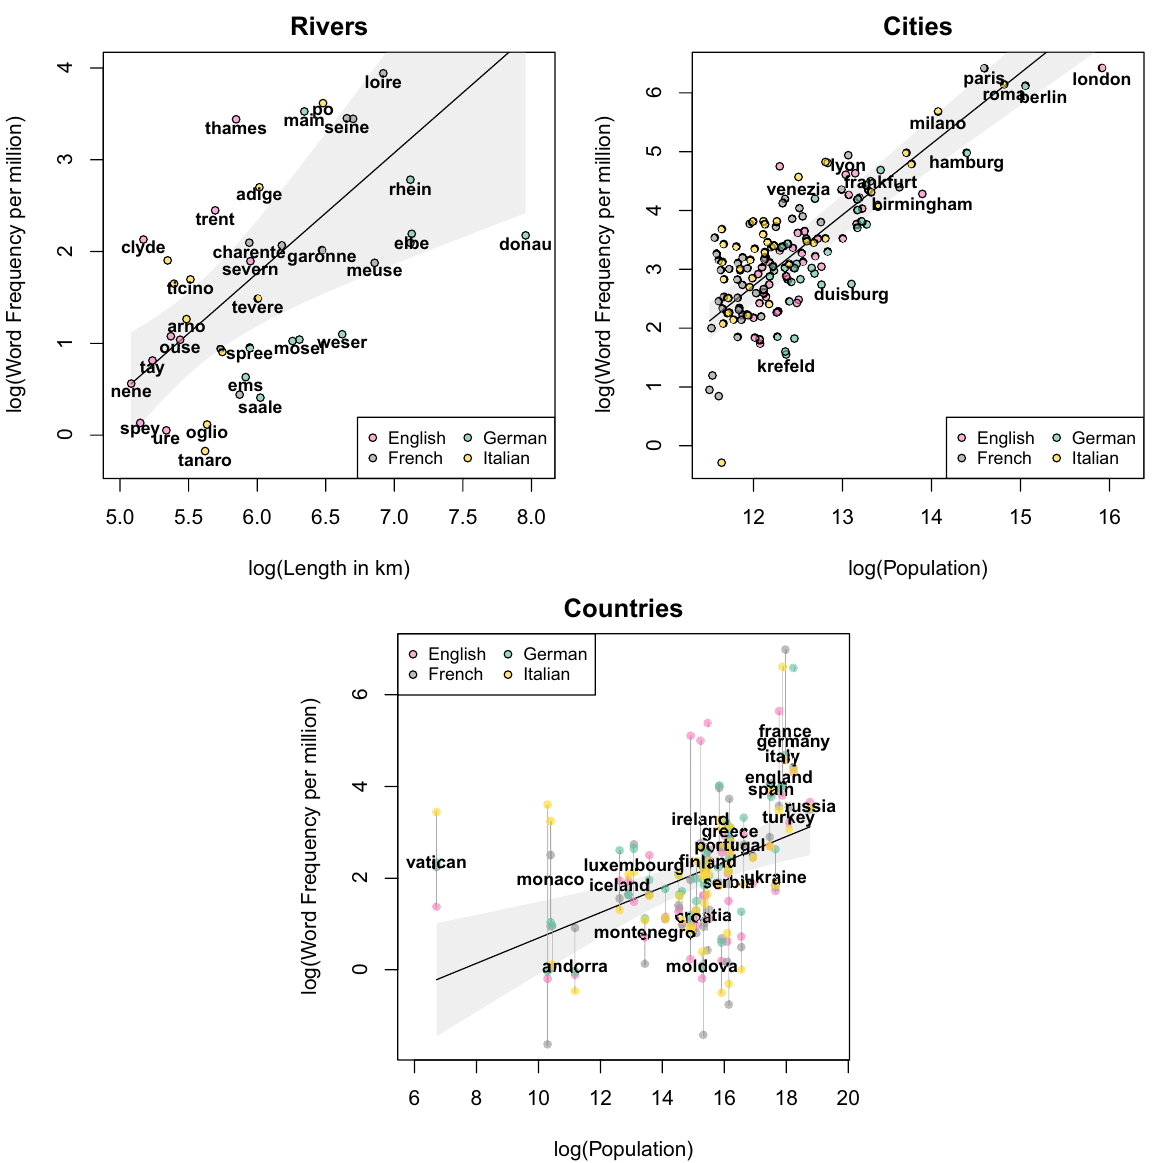
Figure 1. Relation between physical magnitude (river length, city and country population size, which would account for the relevance of these geographical entities) and logarithmic word frequency per million. The solid lines indicates the model prediction, the grey bands around it the 0.95-confidence